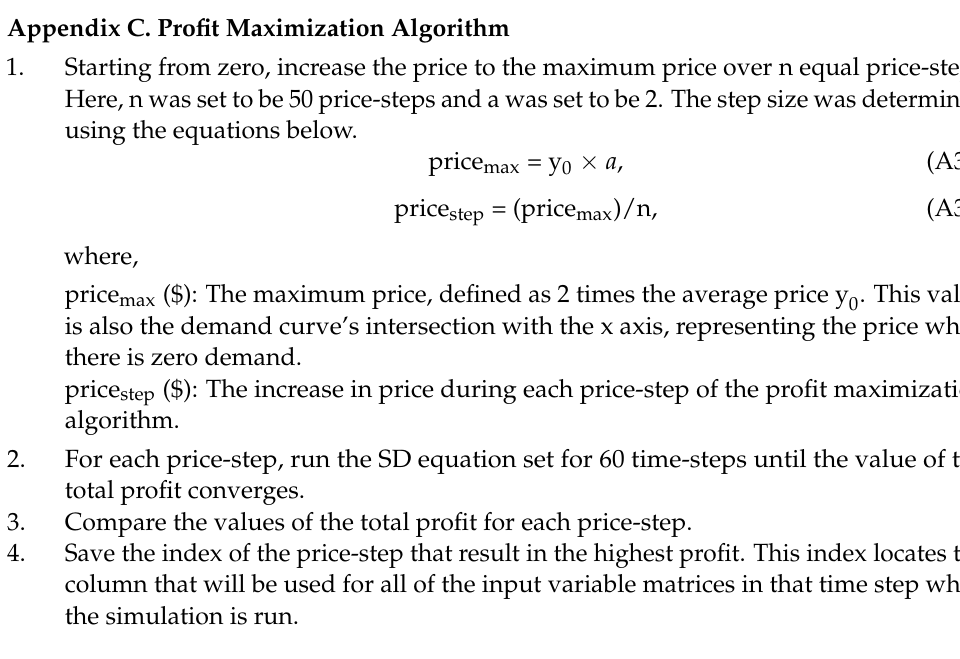
Figure A5. Sub-optimal condition in zone Figure A5. Sub ‐ optimal condition in zone 3.